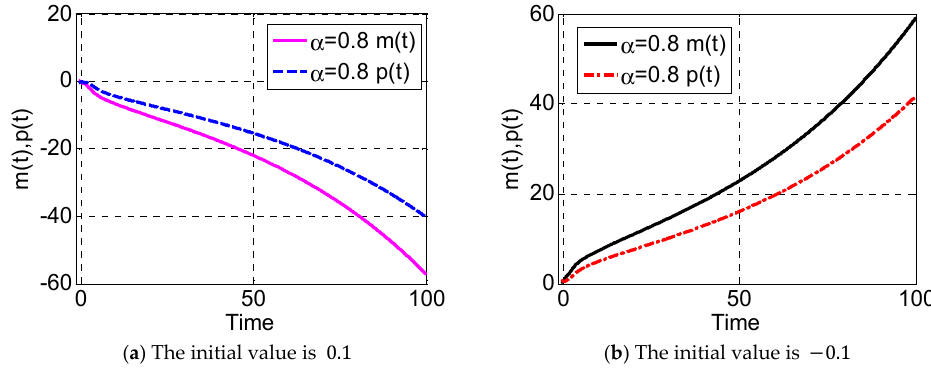
Figure 2. Time response sequence diagram of the two-dimension FOGRN when α = 0.8.